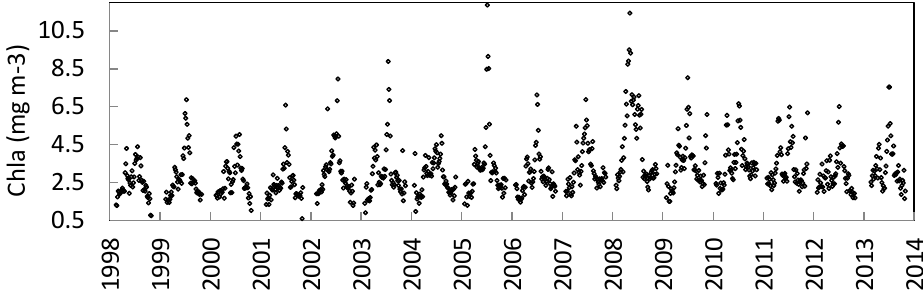
Figure 8. Time series of the 5-day mean CHL (mgm − 3 ) in the central Baltic Sea (area indicated in Fig. 1b) derived from the ESA-CCI processing of SeaWiFS, MERIS and Aqua-MODIS satellite data (Lavender et al., 2015).